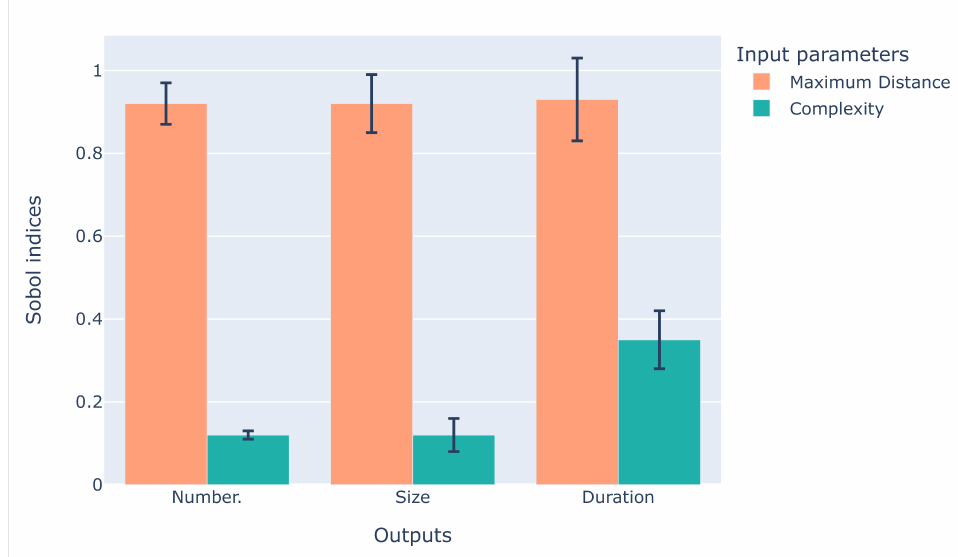
Figure 24. Total sensitivity analysis using the Sobol